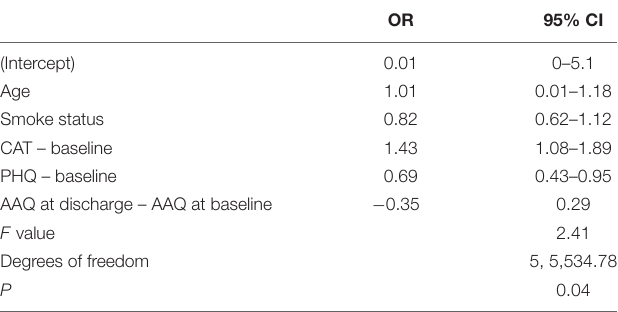
TABLE 3 | Multivariable logistic model including potential predictors of minimum clinically important difference in health status from baseline to the 6-months